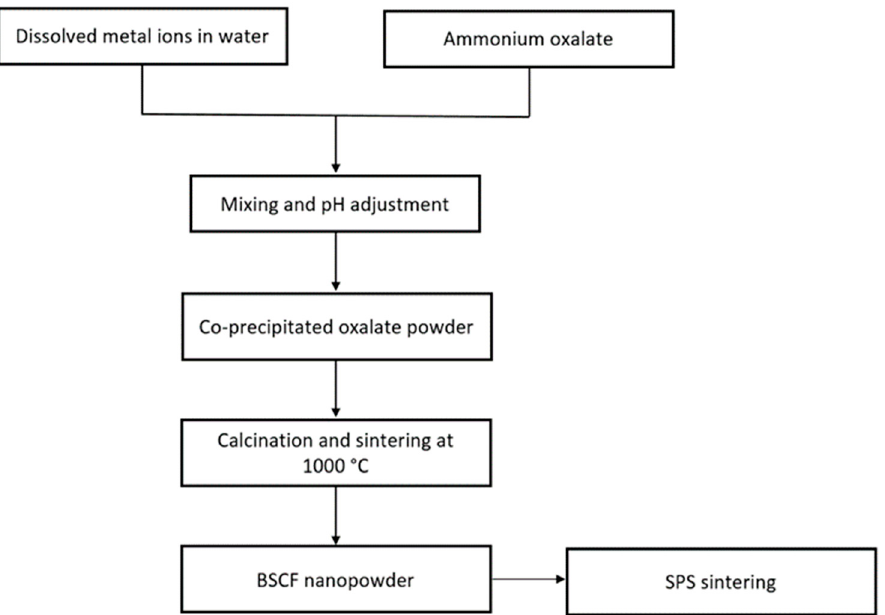
Figure 14. Schematic procedure for the synthesis of BSCF powder by the solution co-precipitation method (Reprinted with permission from [85]). method (Reprinted with permission from